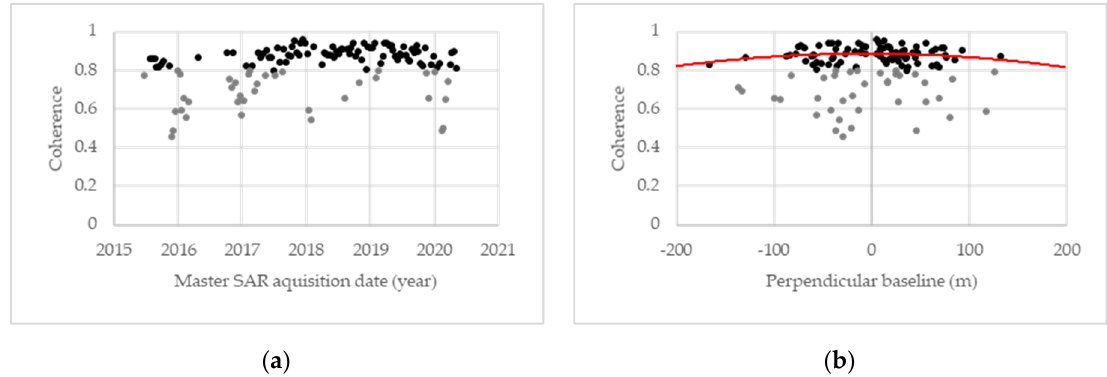
Figure 6. Spatially averaged coherence values for stable points as a function of ( a ) master SAR acquisition date and ( b ) perpendicular baseline. Gray points were excluded from further analysis. The red line is a quadratic regression line (black points only).